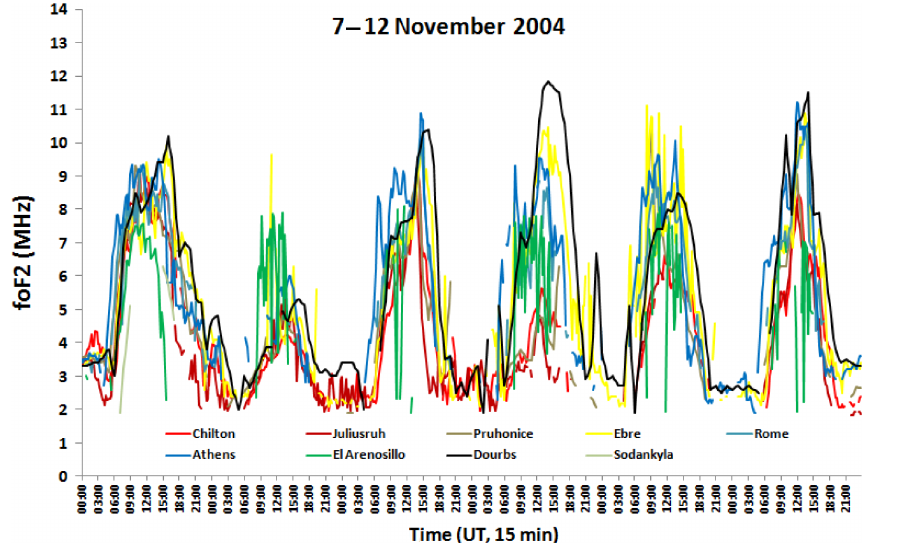
Figure 8. Time variations in fo F2 at Chilton (51.6 ◦ N, 358.7 ◦ E), Juliusruh (54.6 ◦ N, 13.4 ◦ E), Pruhonice (50.0 ◦ N, 14.6 ◦ E), Ebre (40.8 ◦ N, 0.5 ◦ E), Rome (41.9 ◦ N, 12.5 ◦ E), Athens (38.0 ◦ N, 23. 6 ◦ E), El Arenosillo (37.1 ◦ N, 353.2 ◦ E), Dourbes (50.1 ◦ N, 4.6 ◦ E), and Sodankyla (67.4 ◦ N, 26.6 ◦ E) during space weather events over the period 7–12 November 2004.